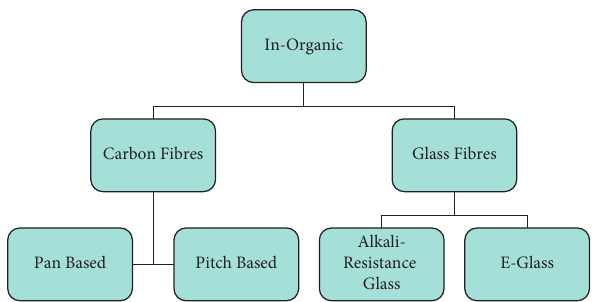
Figure 1: Inorganic structure of different types of fiber laminates.